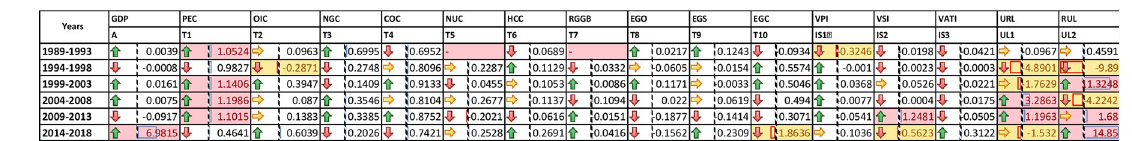
Fig 11. Five years beta. Note: Variable’s definition stated in Table 1.